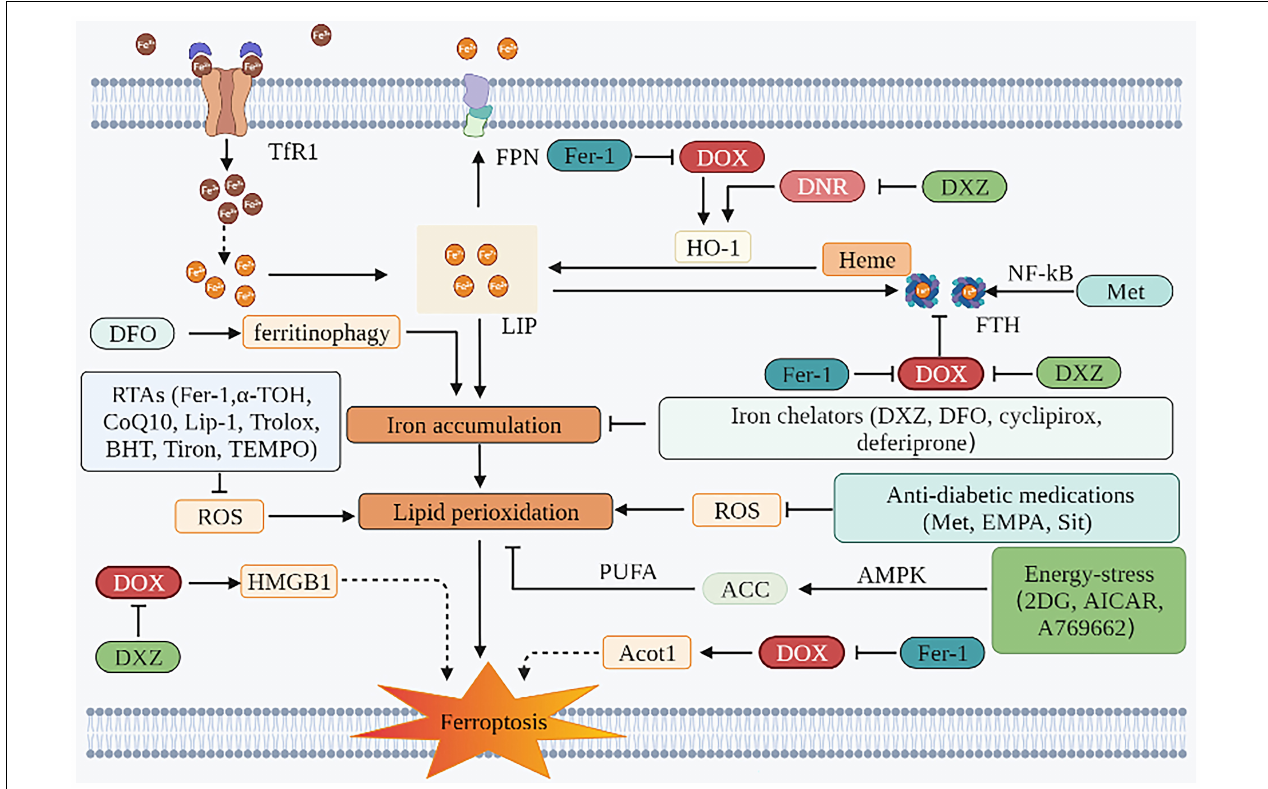
FIGURE 3 | Prevention and SOD treatment of AIC based on ferroptosis. The mechanism of preventing ferroptosis of cardiomyocytes is mainly in two aspects. One is to inhibit iron accumulation, and the other is to inhibit lipid peroxidation. Iron chelators can play a role through the former. The effects of RTAs, anti-diabetic medications, and energy-stress inducers are mainly attributed to the latter. TfR1, transferrin receptor 1; FPN, ferroportin; DOX, doxorubicin; DNR, daunorubicin; LIP, labile iron pool; HO-1, heme oxygenase 1; ROS, reactive oxygen species; Fer-1, ferrostatin-1; DFO, deferoxamine; DXZ, dexrazoxane; PUFA, polyunsaturated fatty acids; ACC, acetyl-CoA carboxylase; AMPK, AMP-activated protein kinase; EMPA, empagliflozin; Sit, sitagliptin; 2DG, 2-deoxy-d-glucose; AICAR, 5-aminoimidazole-4-carboxamide ribonucleotide; HMGB1, high mobility group box 1; HO-1, heme oxygenase 1; FTH, ferritin heavy chain; NF- κ B, nuclear factor-kappa B; α -TOH, α -tocopherol; CoQ10, coenzyme Q10; Lip-1, liproxstatin-1; BHT, butylated hydroxytoluene; Acot1, acyl-CoA thioesterase 1; TEMPO, 2,2,6,6-tetramethylpiperidin-N-oxyl; Met,